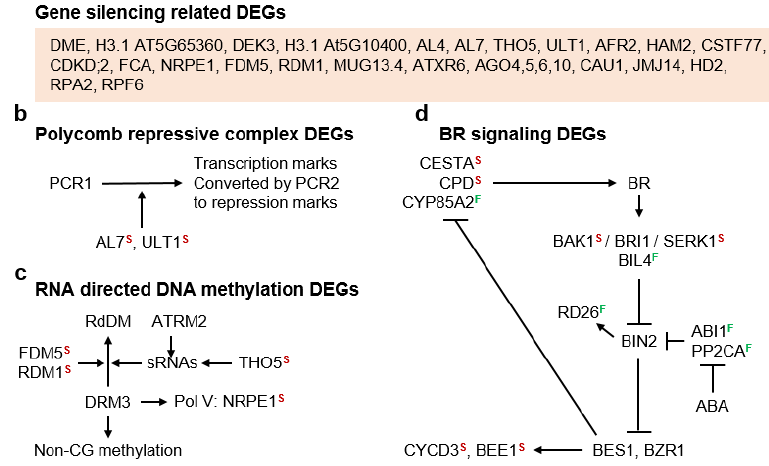
Figure 5. Differentially expressed genes (DEGs) observed between diplosporous Boechera x formosa and sexual Boechera stricta (see Tables S5 and S9) as associated with: ( a ), gene silencing; ( b ), polycomb repressive complex formation, ( c ), RNA directed DNA methylation, and ( d ), brassinosteroid (BR) signaling. Superscripts identify taxa in which DEGs are upregulated; F, B. x formosa ; S, B. stricta ; red highlights, upregulation in sexual B. stricta ; arrows indicate upregulation or activation; blunt end lines represent downregulation or suppression.